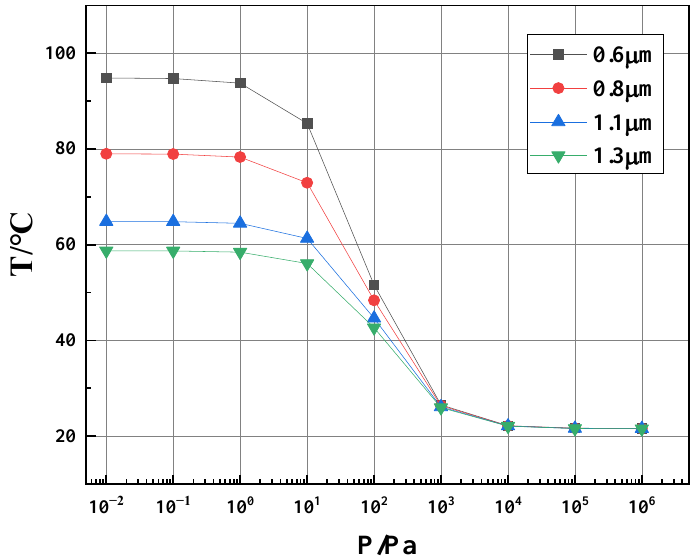
Figure 5. Simulated thermistor temperature as the function of air pressures for different dielectric thicknesses.